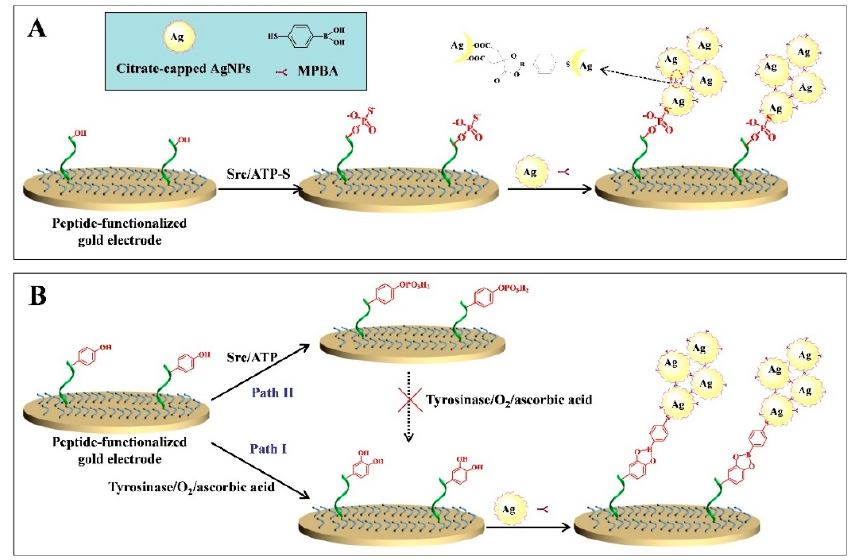
Figure 6. Schematic representation of the proposed electrochemical strategies for protein kinase detection based on the in situ formation of the AgNPs aggregates as labels. In the first design ( A ), ATP-S was used as the co-substrate. In the second design ( B ), ATP was used as the co-substrate, and tyrosinase was used to convert monophenol into o-diphenol [68]. Copyright 2017 Elsevier B.V.